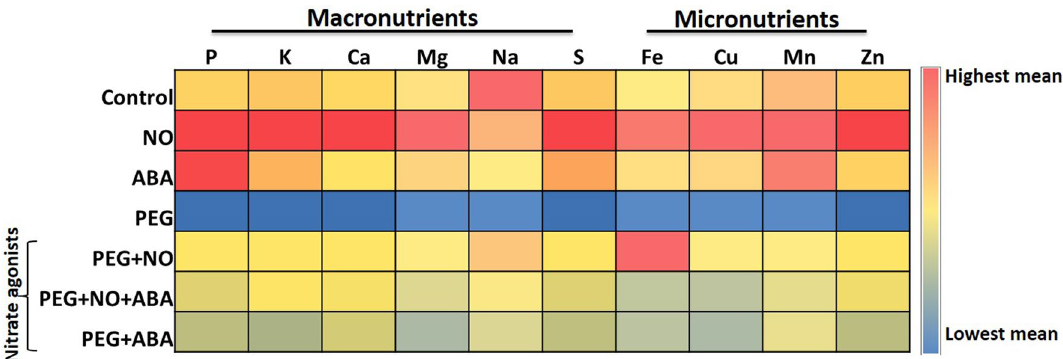
Figure 5. Heat map represents ICP-MS content of macro (P, K, Ca, Mg, Na, and S) and micronutrients (Fe, Cu, Mn, and Zn) of 7-d-old B. juncea L. roots after treatment with PEG (10%) and its combination with NO (100 µM) and ABA (10 µM) (nitrate agonists) for 96 h. Values are mean ± S.E. of three independent experiments, each including four biological replicates.